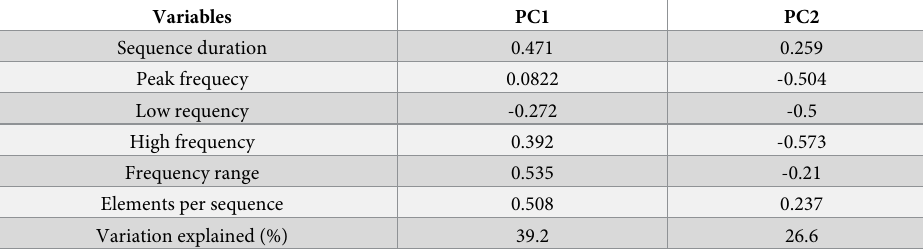
Table 2. Loading scores of the first two principal components from the T . browni songs’ acoustic traits.